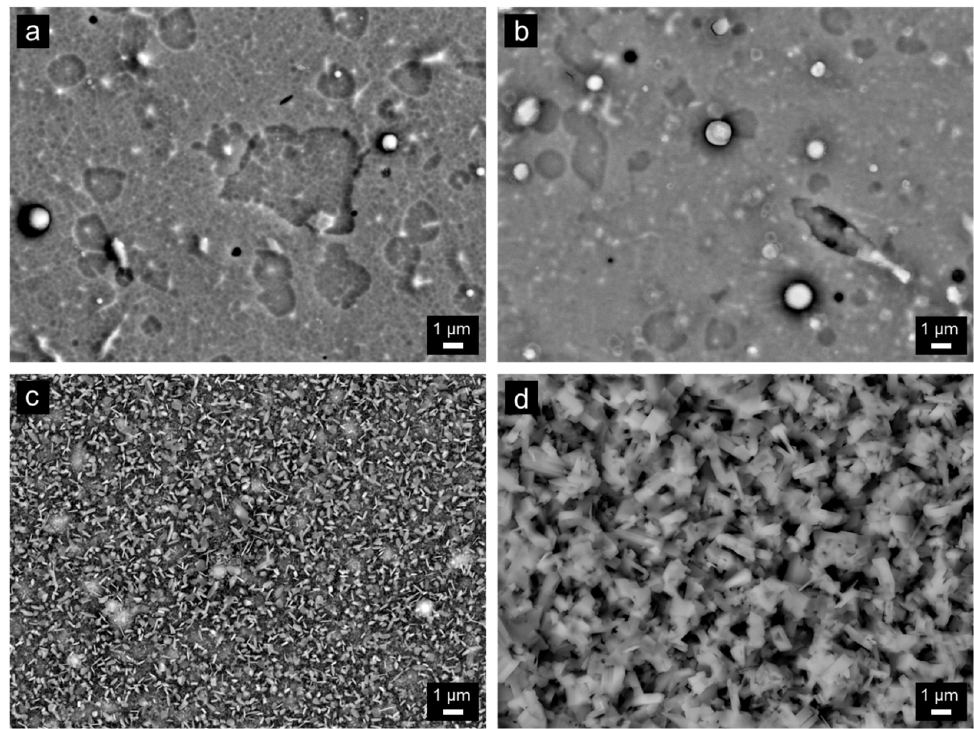
Figure 5. SEM images of the surface morphology of the coatings after annealing in air at 700 °C ( a ), 800 °C ( b ), 900 °C ( c ) and 1000 °C ( d ) for 1 h. EDX elemental maps of the cross-sections of the annealed samples are given in Figure 6.